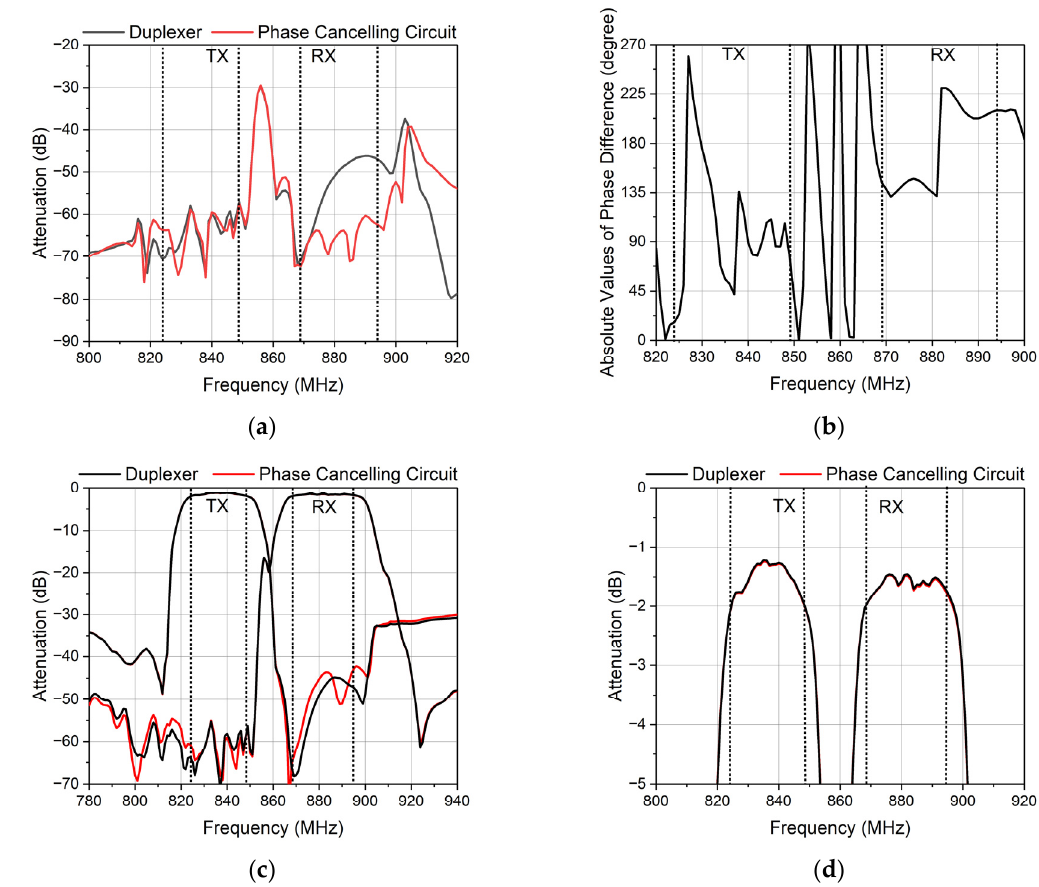
Figure 14. The measured characteristics of the duplexer and the phase canceling circuit. ( a ) The isolation of the duplexer and the phase canceling circuit. ( b ) The absolute values of the phase difference of the feedback signal and the leakage signal. ( c ) The attenuation of the duplexer and the phase canceling circuit. ( d ) The insertion loss of the duplexer and the phase canceling